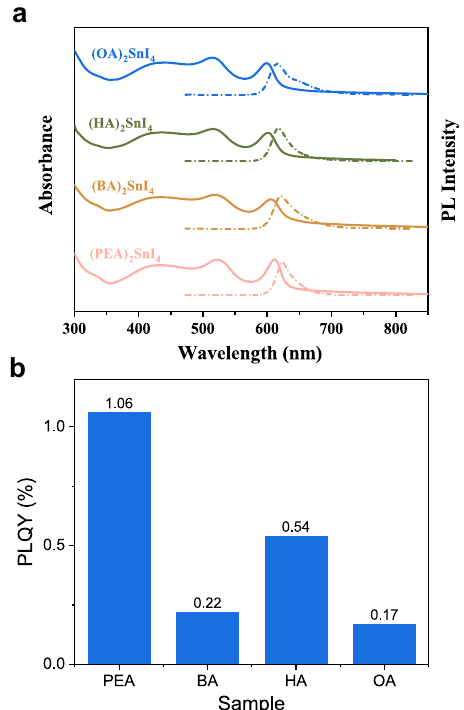
Fig. 2 The absorption and PLQY of the four perovskites. a The absorption (solid line) and PL spectra (dot line) of (PEA) 2 SnI 4 (magenta), (BA) 2 SnI 4 (tawny), (HA) 2 SnI 4 (dark green), and (OA) 2 SnI 4 (blue). b The corresponding PLQY of the four